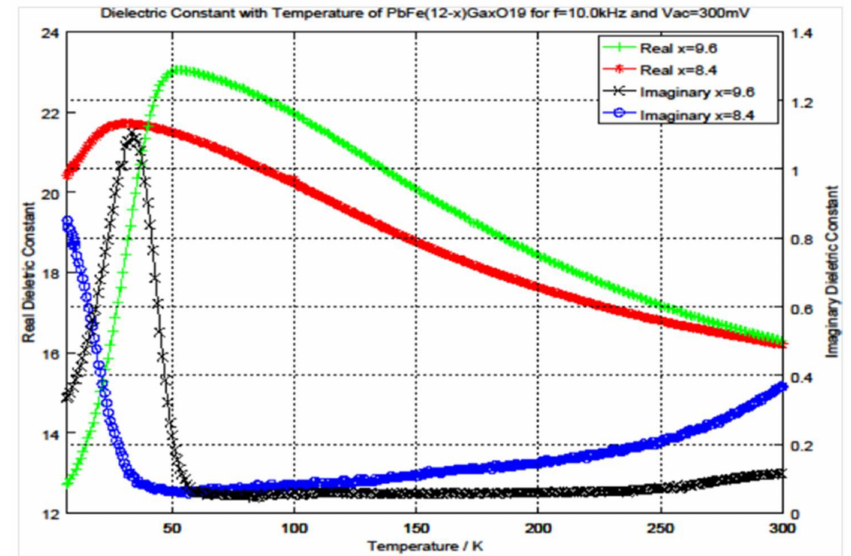
Figure 2. Real and imaginary parts of the dielectric constant for Ga-substituted PbFe 12 O 19 . The dependence of T c upon the percentage x of Ga substituted for Fe varies experimentally as T c = A(x − x c ) 2/3 , which is in agreement with the theoretical value [16] of 0.63 for a similar fcc structure (the percolation value for the exact PbFe 12 O 19 structure has not been published); however, Lorenz et al. suggest that it is the same as for fcc: [17]. The value x c has also been calculated and is in agreement with theory.